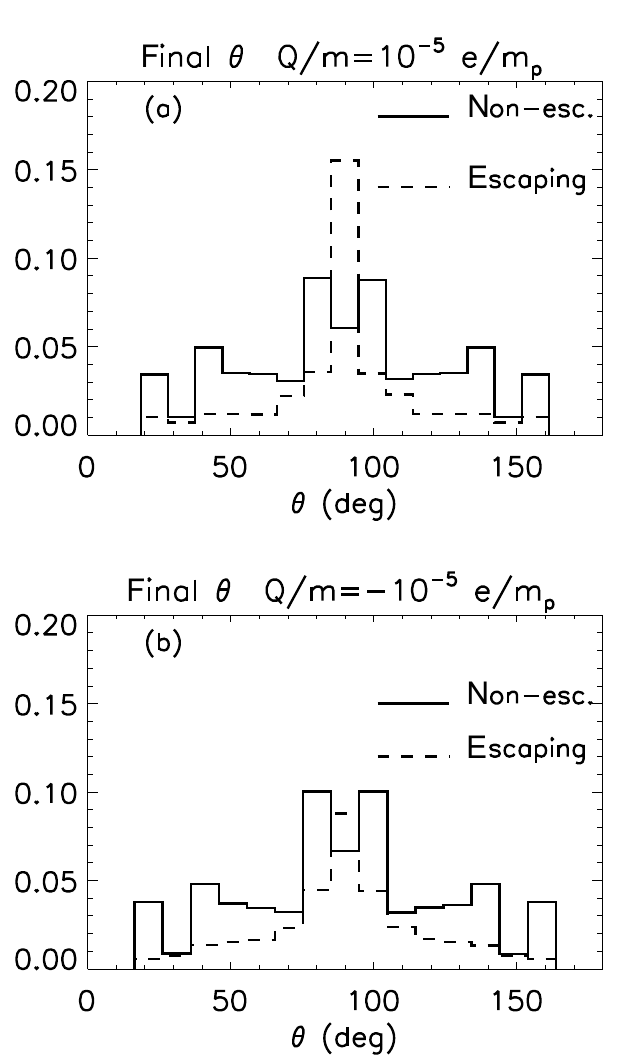
Figure 7. The distributions over final values of solar colatitude θ for the nanodust particles with (a) Q/m = 10 − 5 e/m p and (b) Q/m = − 10 − 5 e/m p . For escaping particles (dashed line), there is a narrow peak near the solar equator ( θ = π/ 2) for both signs of Q